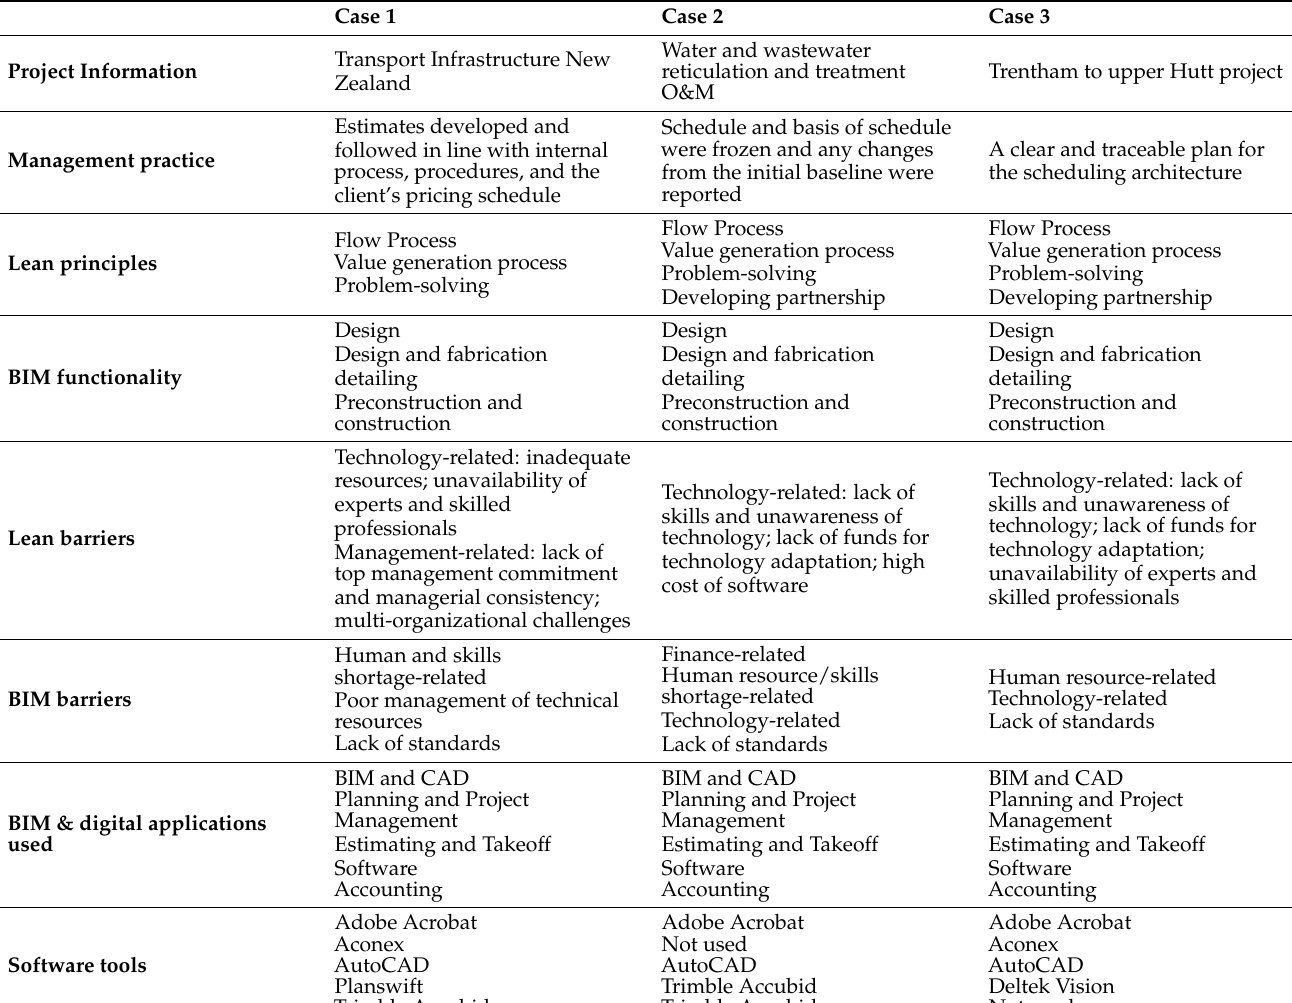
Table 6. Case studies comparison